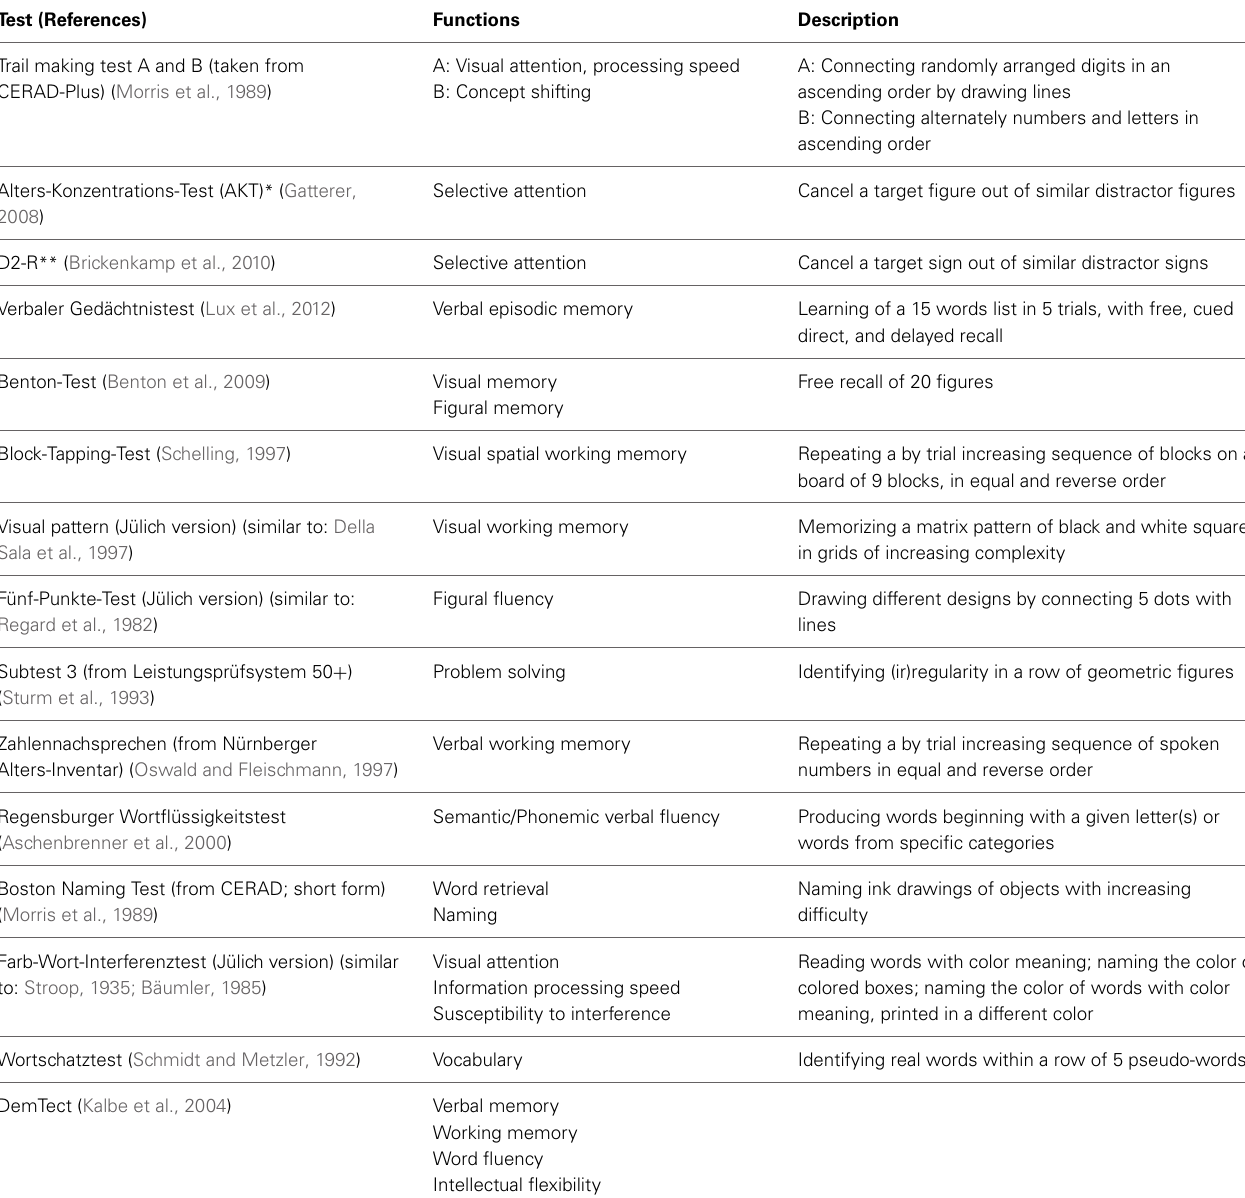
Table 2 | Neuropsychological performance tests as administered in